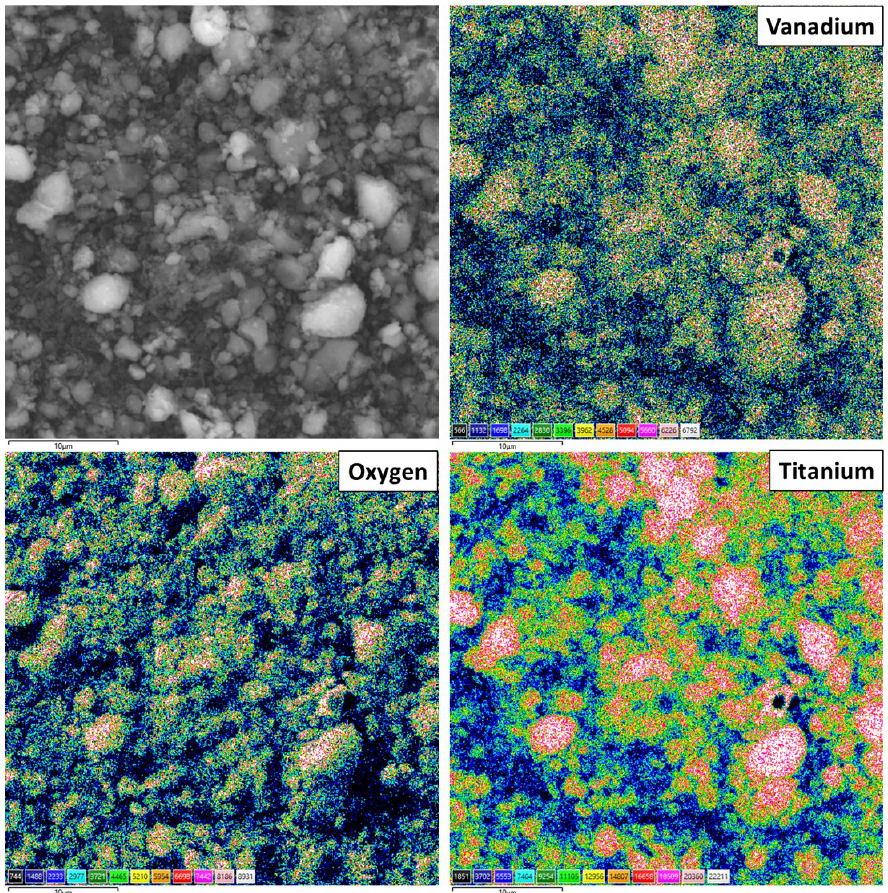
Figure 5. SEM image and EDS concentration maps of V, O and Ti for the sample S 2 V 1 Ti 1 .